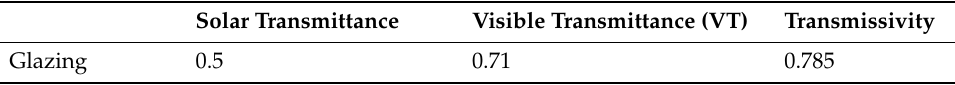
Table 7. Characteristics of the glazing.